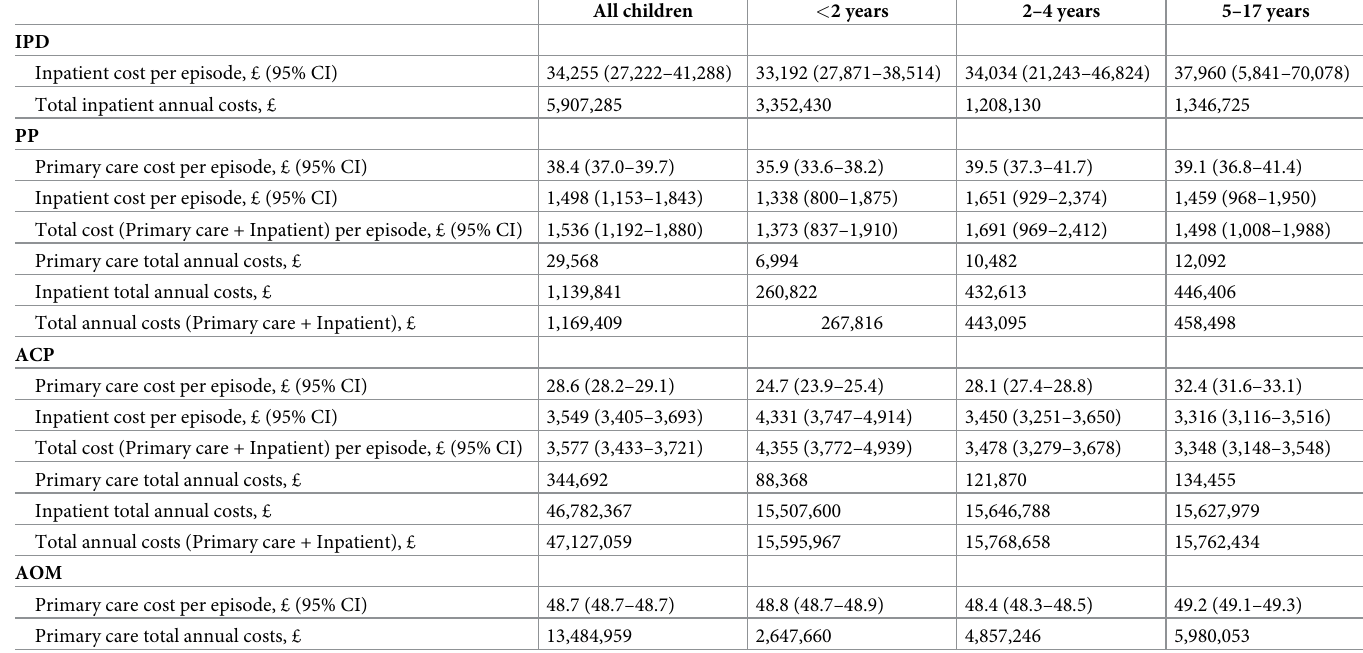
Table 3. IPD, PP, ACP and AOM costs per episode by age groups overall the study period